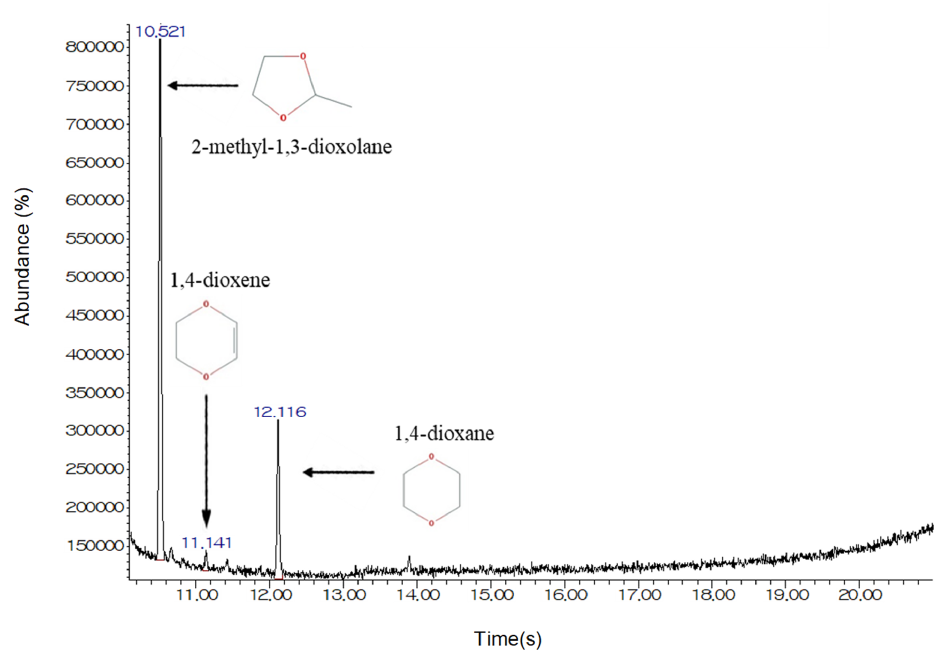
Figure 10. GC/MS analysis of wastewater from the textile industry.